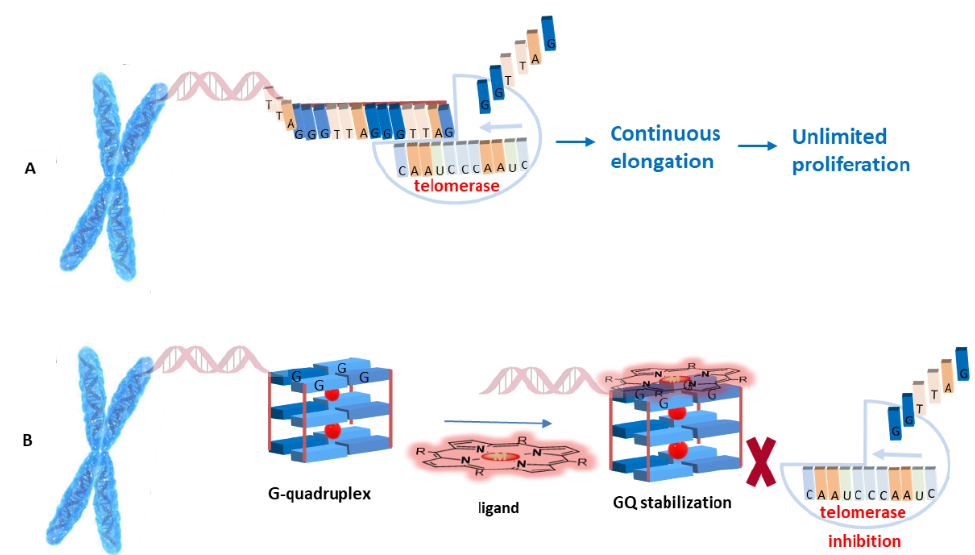
Figure 6. ( A ) Telomere end elongation by telomerase; ( B ) G-quadruplex-ligand adduct formation for indirect telomerase inhibition.